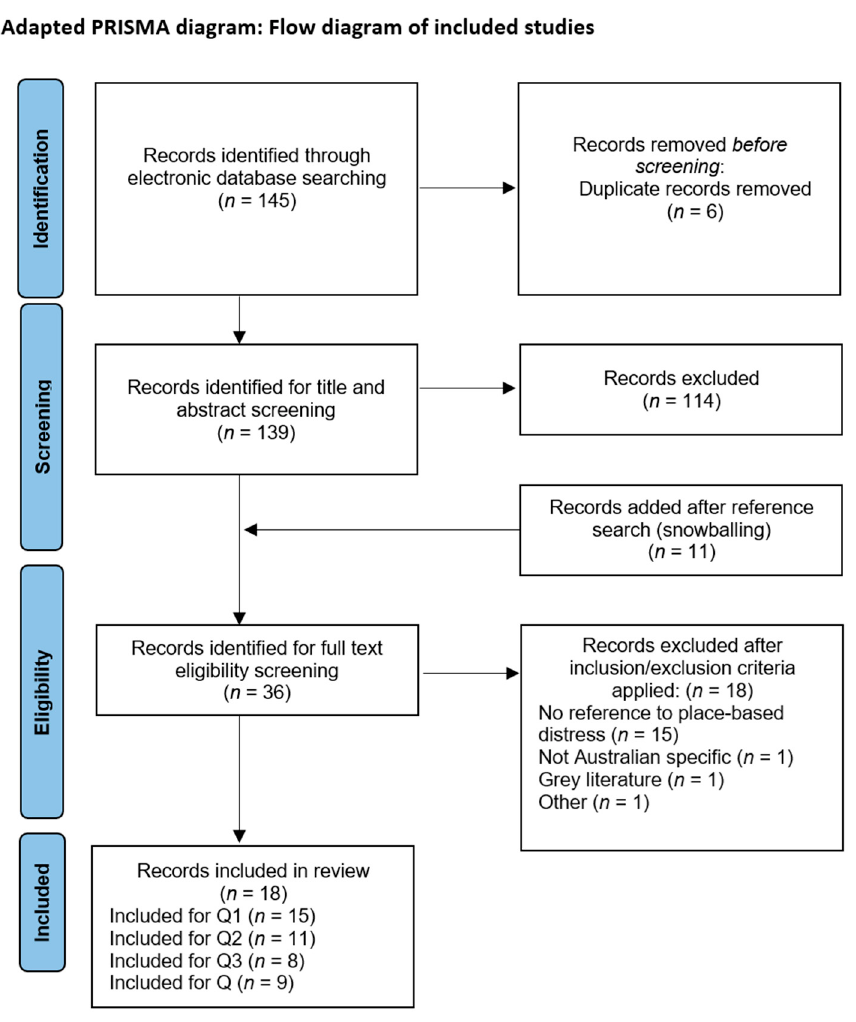
Figure 1. PRISMA diagram visually displaying search results.